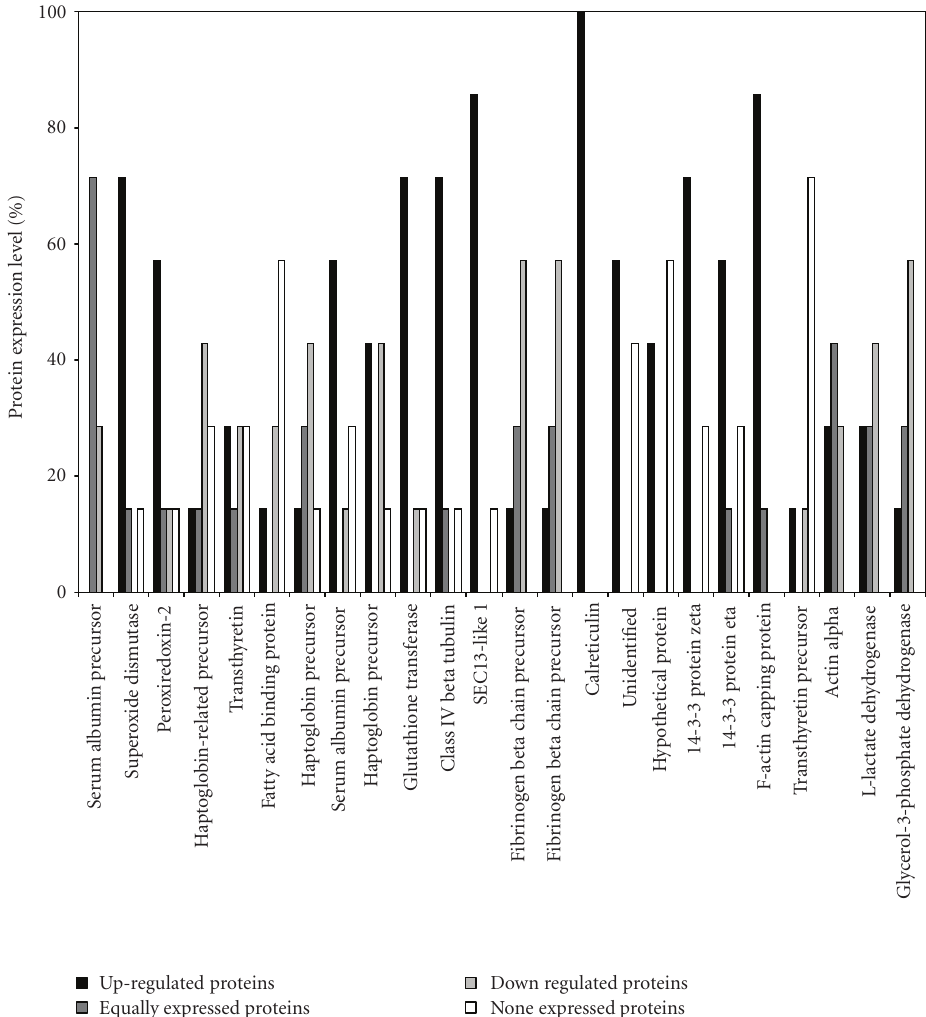
Figure 8: Distribution of proteins in Grade II